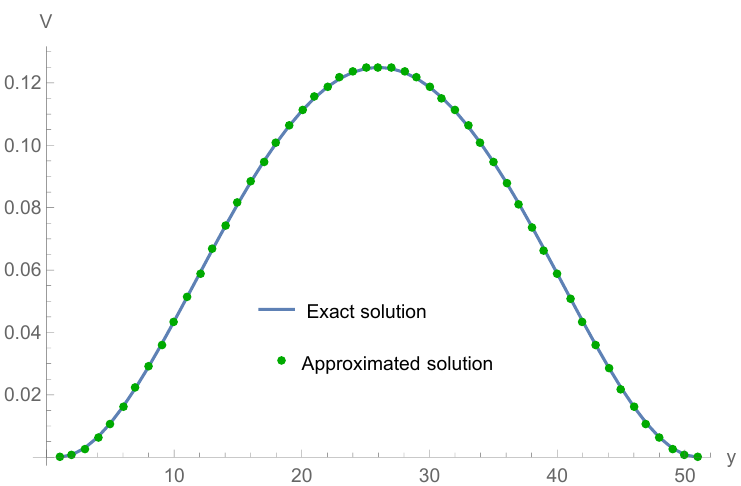
Figure 3 . Comparison of the exact and the computed values at γ = 0.5 and α = 0.01. Example 2. Take the FPIDE with and